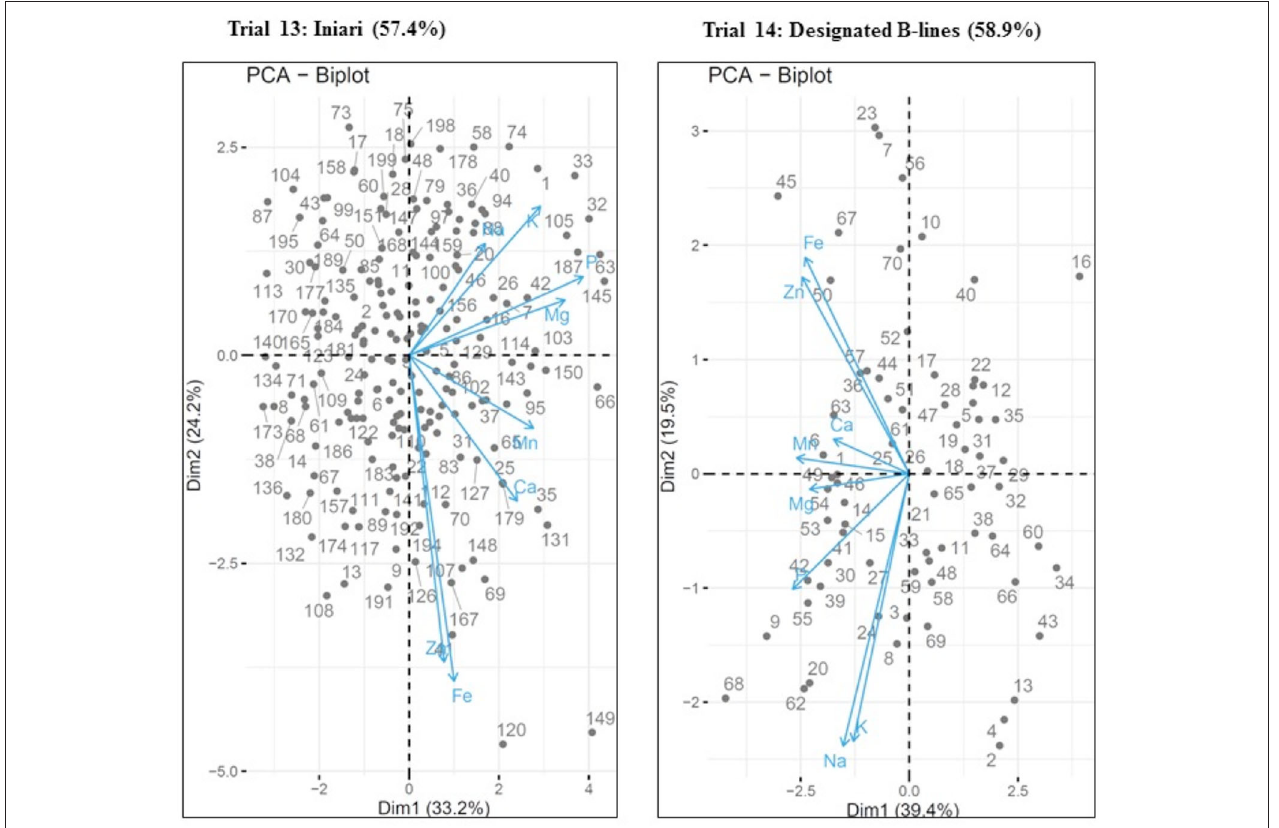
FIGURE 3 | Genotype by trait (GT) biplot of 14 pearl millet trials for grain macronutrient and micronutrient